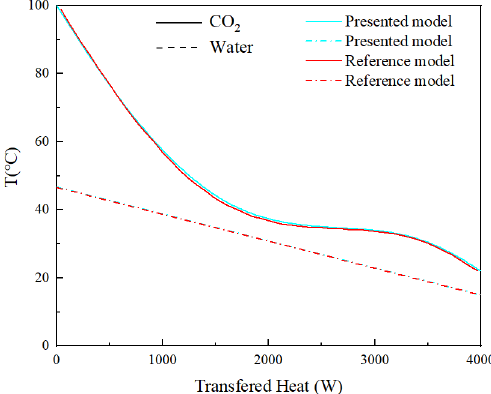
Figure 5. Validation of the presented model with the study by Yun-Guang Chen [41] .